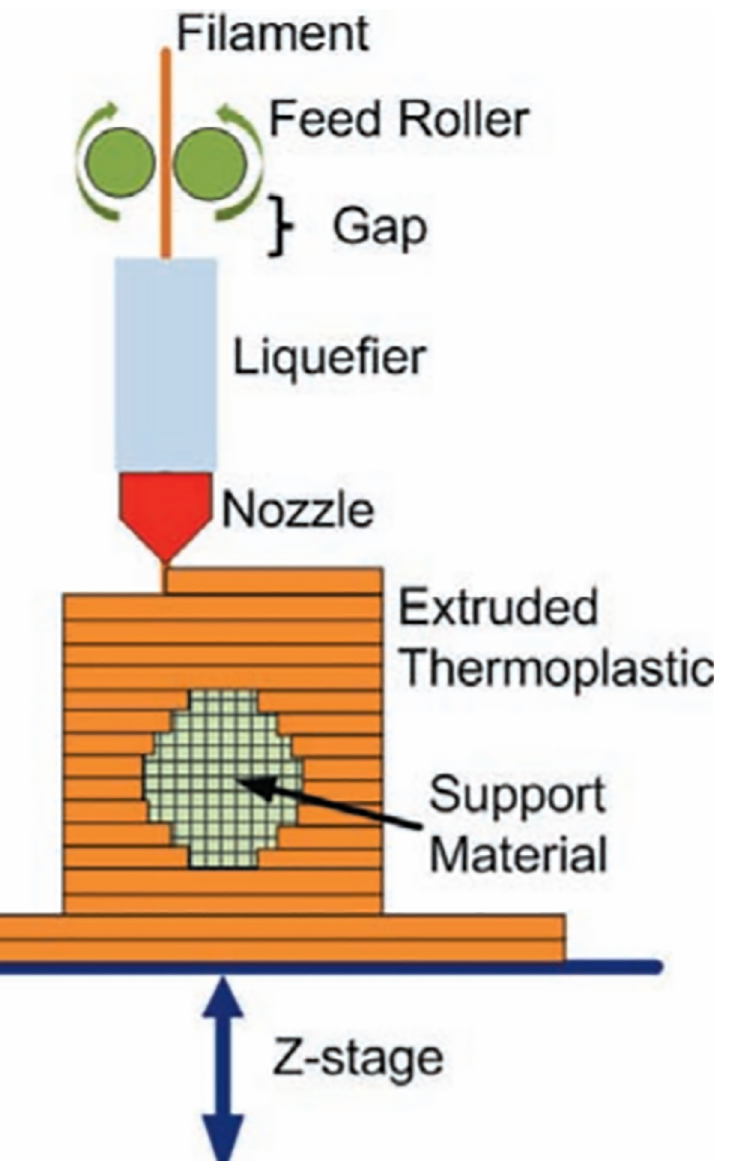
Fig 4. FFF printing system. Diagram showing the basis of the FFF technique. Source: [34].